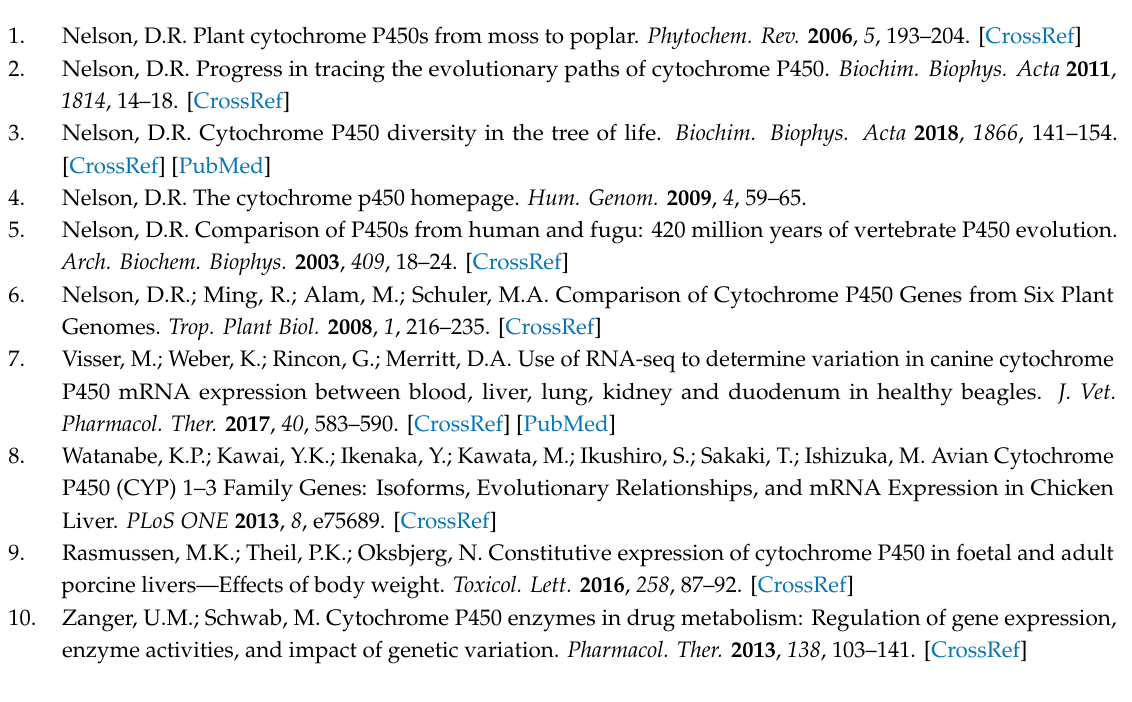
Table S1: All primers used in this study, Table S2: Information of cCYP genes, Table S3: Expression levels of cCYPs in developing chicken